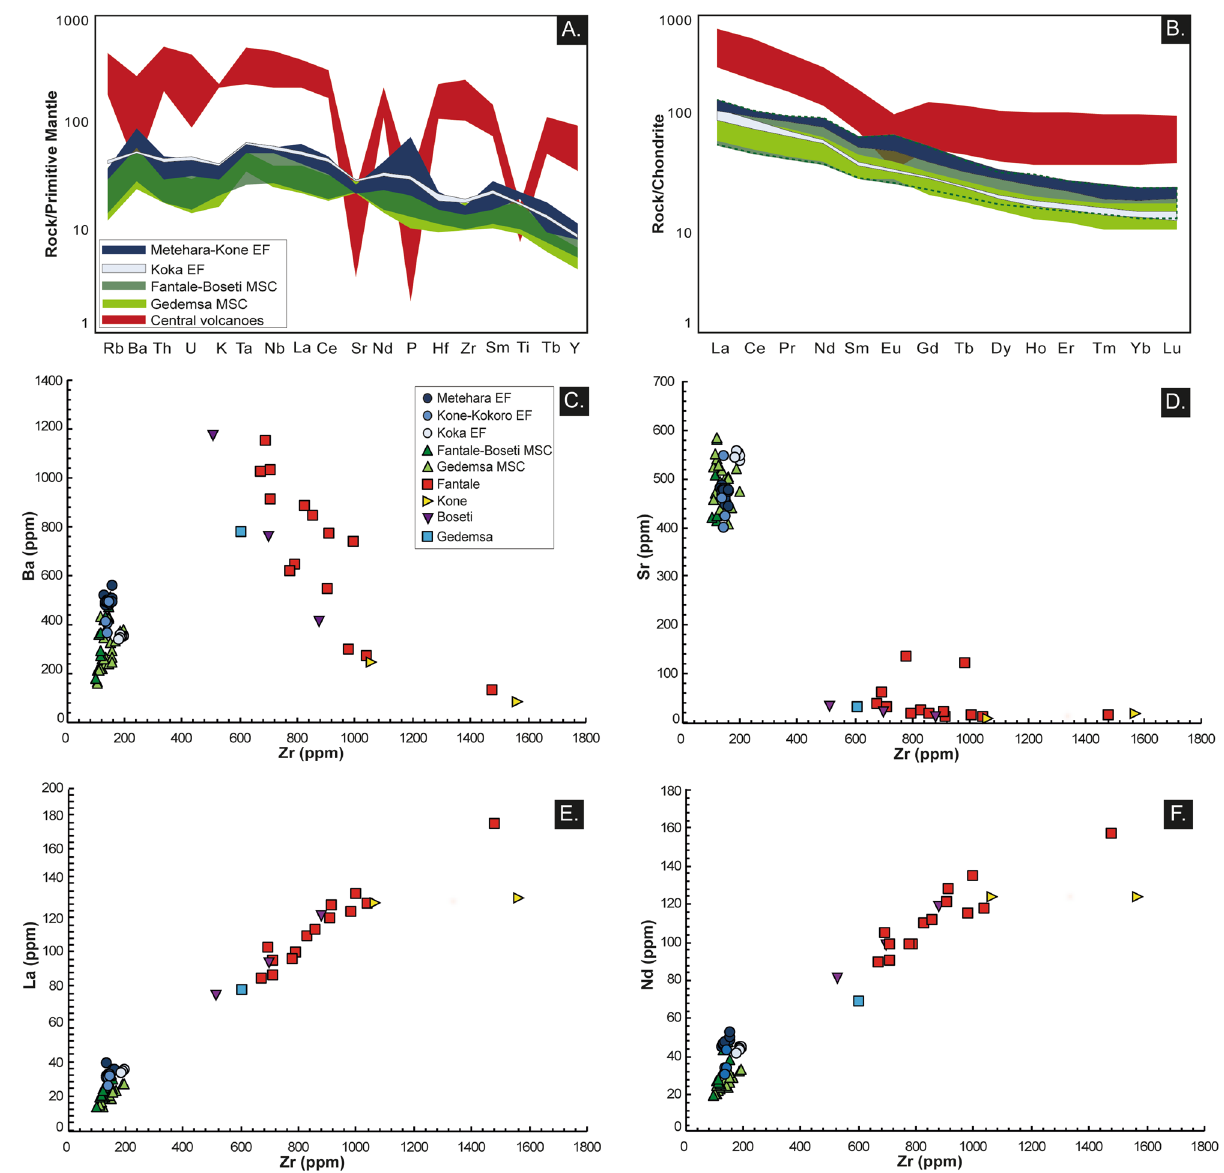
Figure 6. Normalized spider and selected trace element diagrams. ( A,B) Spider and REE diagrams for the analysed products. Compositions of central volcanoes could be also one order of magnitude more enriched with respect to the EF and MSC products. Notably, central volcanoes present deep negative anomalies in Sr and P and a slight negative anomaly in Eu, suggesting prominent fractionation processes involving plagioclase and apatite. ( C–F) Zr vs. selected trace element diagrams for the entire dataset, including central volcanoes. No mixing trends can be observed between basic (EF + MSC) and rhyolitic